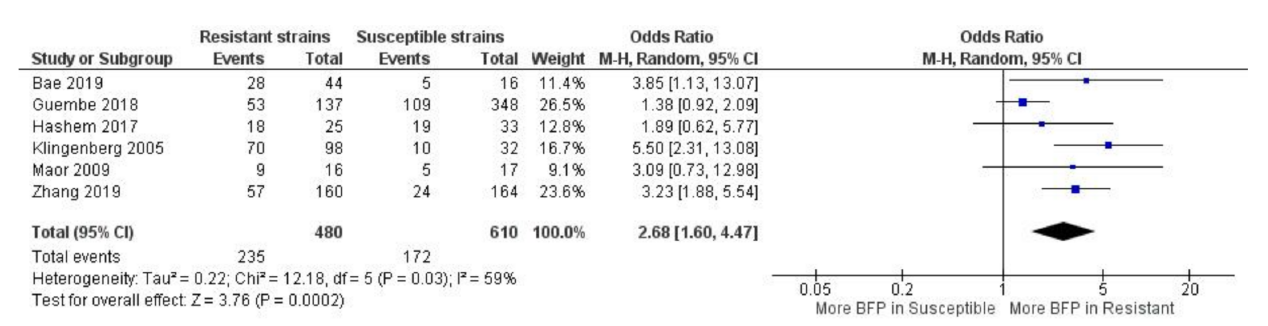
Figure 3. Forest plot of BFP (biofilm production) prevalence in resistant vs. susceptible strains—BSIs (Bloodstream Infections). “Tau 2 ” represents the absolute value of the true variance (amount of heterogeneity). “Chi 2 ” is the chi-squared test of the null hypothesis that there is no heterogeneity.”df” are degrees of freedom. “P” represents the p -value. The “I 2 ” statistic describes the percentage of variation across studies that is due to heterogeneity rather than chance. “Z” is the z-statistic, which are significance tests for the weighted average effect size. “CI” stands for confidence interval. “M-H” is the Mantel-Haenszel analysis